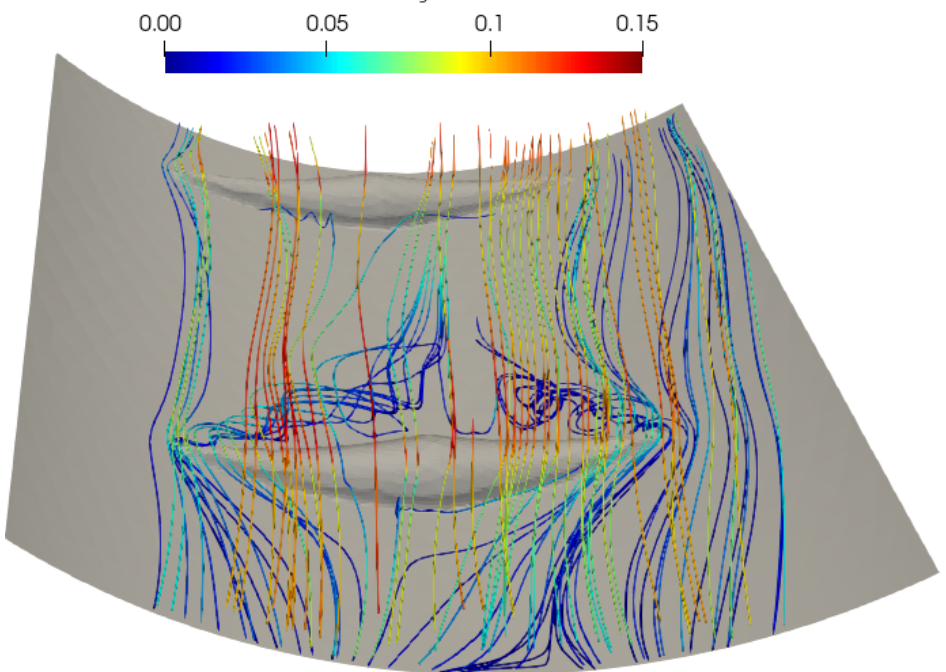
Figure 13. Streamlines of the magnitude velocity, over an interrupted